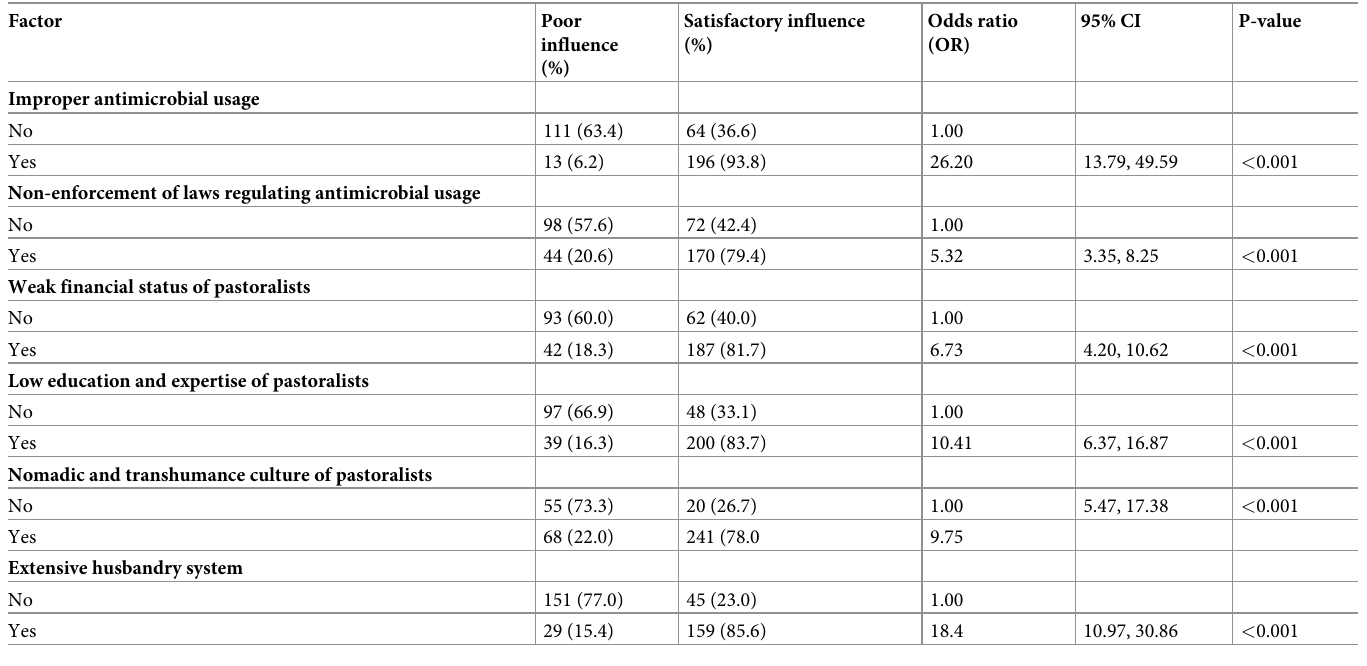
Table 5. Socio-economic factors that influence antimicrobials misuse by pastoralists and resistance emergence in lactating cows in North-central